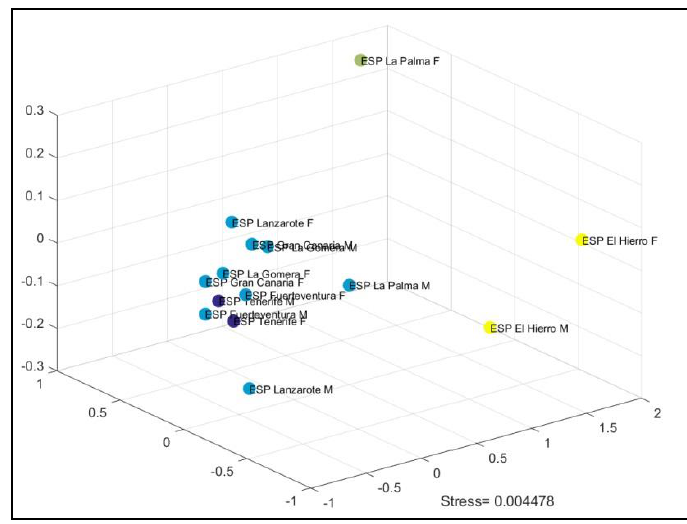
Figure 13. Three-dimensional MDS of SVO interrogative sentences with the value of Stress.